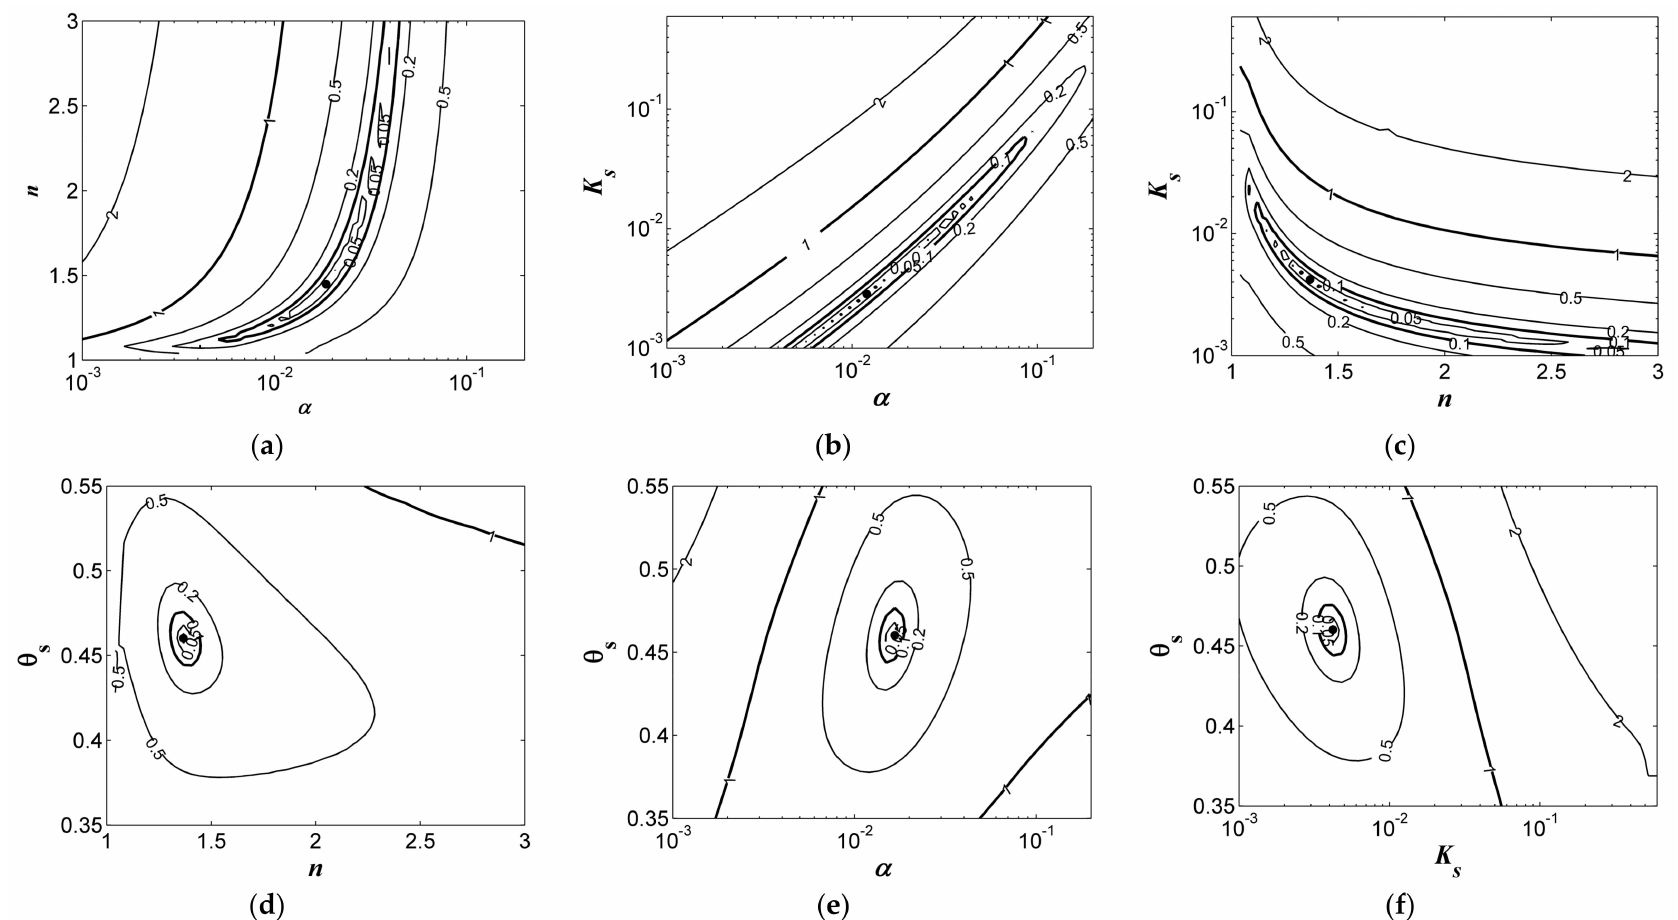
Figure 4. Contours of objective function ψ ( θ final ) of silt under θ initial equal to a 40% effective saturation degree. The hydraulic parameters of silt: θ r = 0.034 cm 3 cm − 3 ; θ s = 0.46 cm 3 cm − 3 ; α = 0.016 cm − 1 ; n = 1.37; K s = 0.0042 cm min − 1 . Results are plotted in the: ( a ) α – n ; ( b ) α – K s ; ( c ) n – K s ; ( d ) n – θ s ; ( e ) α – θ s ; and ( f ) K s – θ s parameter planes. The solid circles are the true